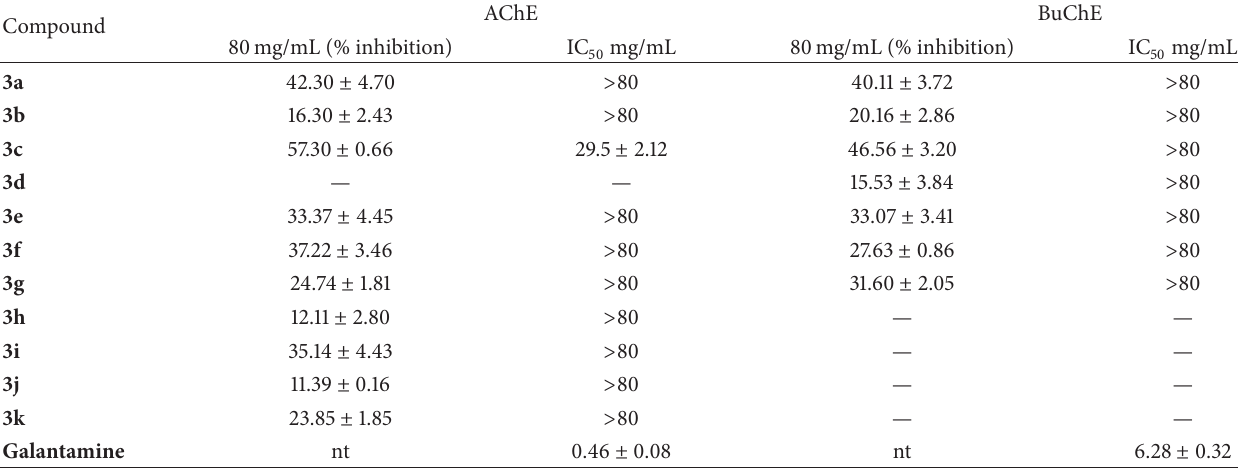
Table 2: Cholinesterase inhibitory activity and IC 50 values ( 𝜇 g/mL) of compounds ( 3a–k ).